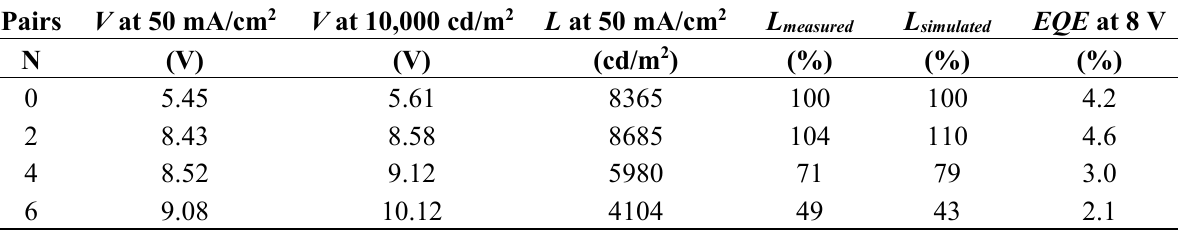
Table 1. Comparison of measured voltage, ( V at 50 mA/cm 2 and V at 10 kcd/m 2 ) and measured luminance ( L at 50 mA/cm 2 ) with the simulated luminance L simulated in percent normalized to reference organic light emitting diodes (OLED) depending on the distributed Bragg reflector (DBR)